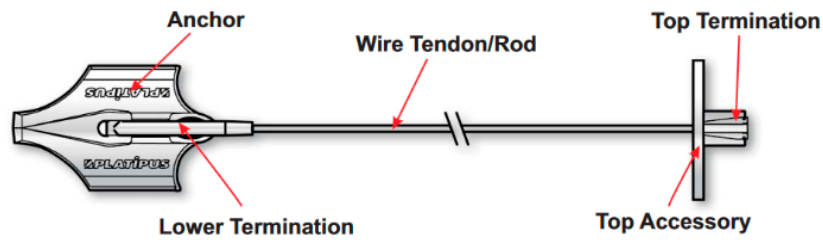
Figure 1. Components of PDEA [31].